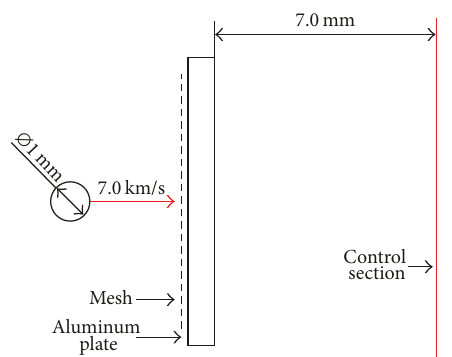
Figure 2: Initial setup for numerical experiments on combined mesh/plate